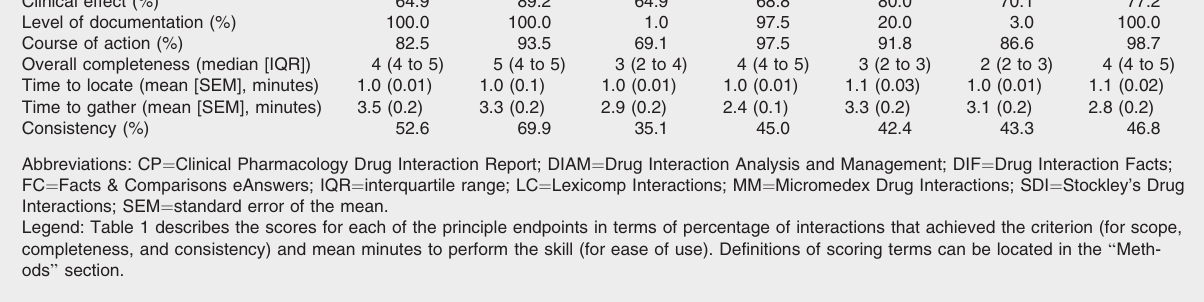
Table 1 Study results for scope, completeness, ease of use, and Interactions and Clinical Pharmacology Drug Inter- action Report). Scope scores were higher for Lex- icomp Interactions, Clinical Pharmacology Drug Interaction Report, and Micromedex Drug Interac-